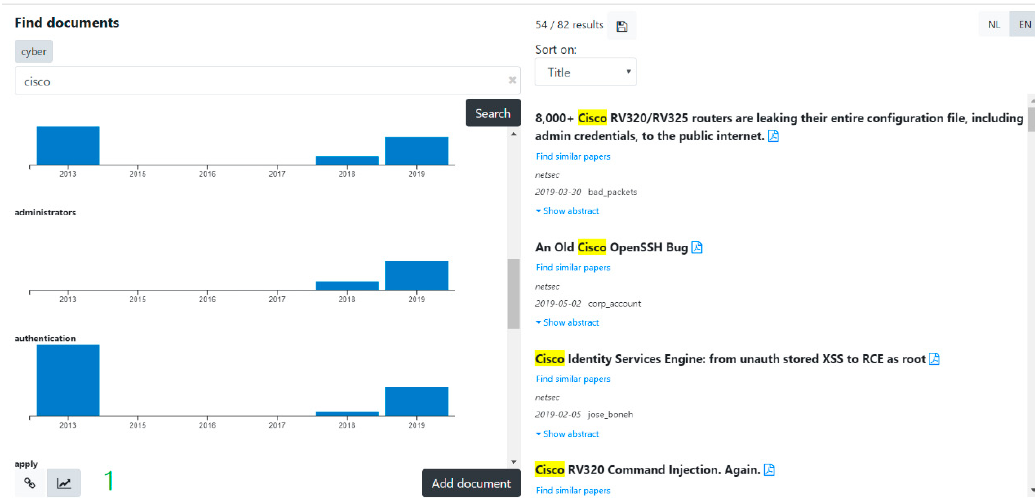
Figure 4. Result screen of the Horizon Scanner tool with the trend analysis.